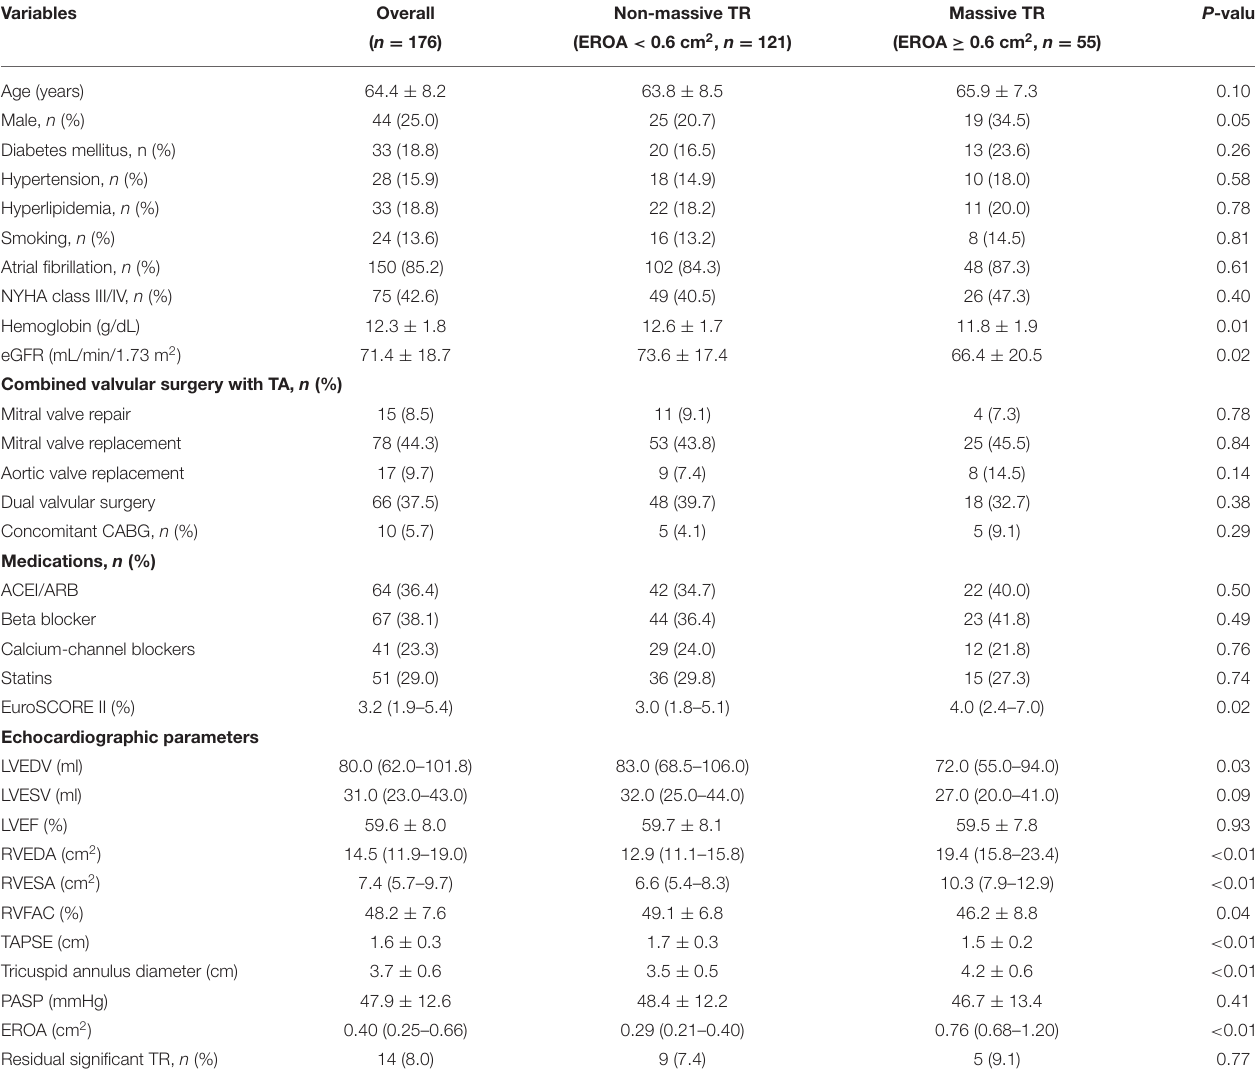
TABLE 1 | Baseline characteristics of the study population.